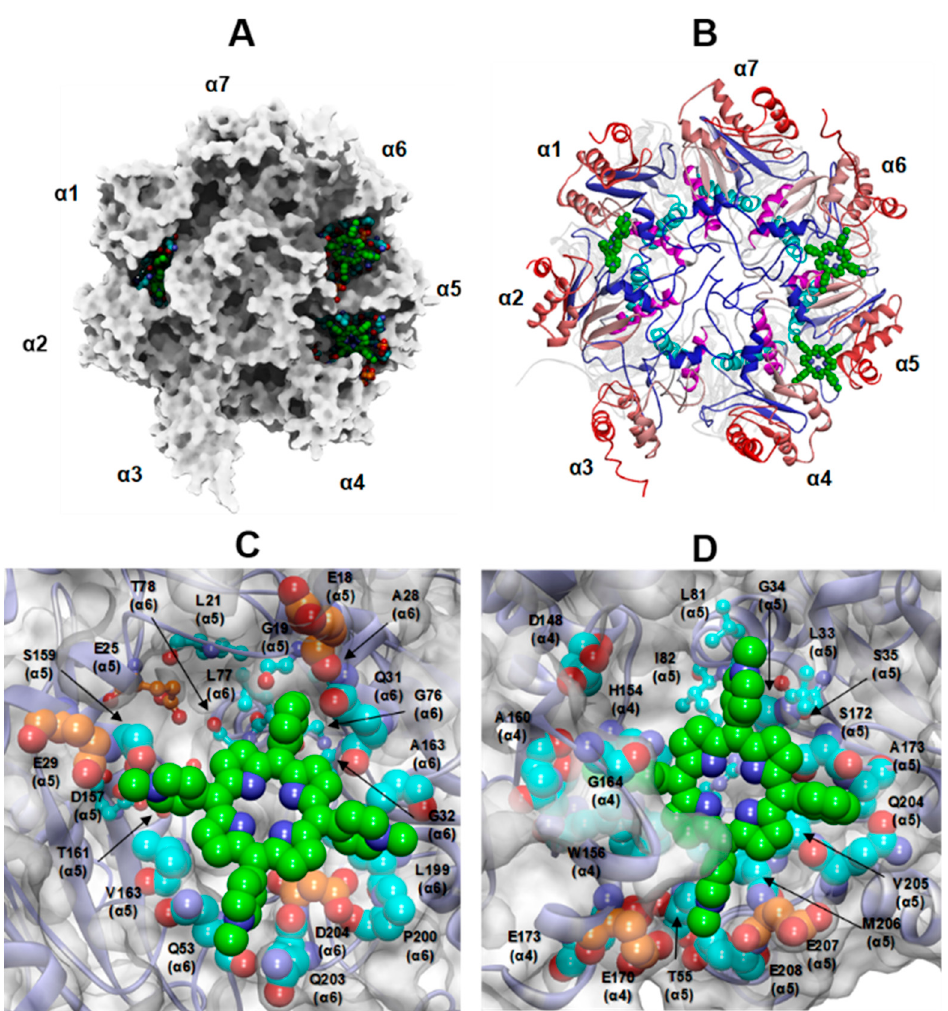
Figure 9. ( A , B ) Top view of the selected docked complex of three Tris-T4 molecules bound to human 20S (closed conformation). ( A ): the protein is displayed as Connolly surface and coloured in grey except for residues involved in interactions with Tris-T4, which are displayed as CPK. ( B ): the protein is displayed in ribbons and secondary structure elements of each subunit are sequentially coloured from N- to C-terminal end ( α H0 = blue; α H1 = cyan; α H2 = magenta, α H3- α H5 = light red to dark red). C-D: Close up view on the ligand binding site at the α 5– α 6 ( C ) and α 4– α 5 ( D ) grooves. Tris-T4 is coloured by atom type (C: green; N: blue). The residues involved in interactions with Tris-T4 are displayed in CPK and coloured: orange (negative residues involved in ionic interactions with RPs) and cyan (residues not engaged in RP interactions). The residues involved in interactions with RPs hydrophobic motif are evidenced in ball&stick.